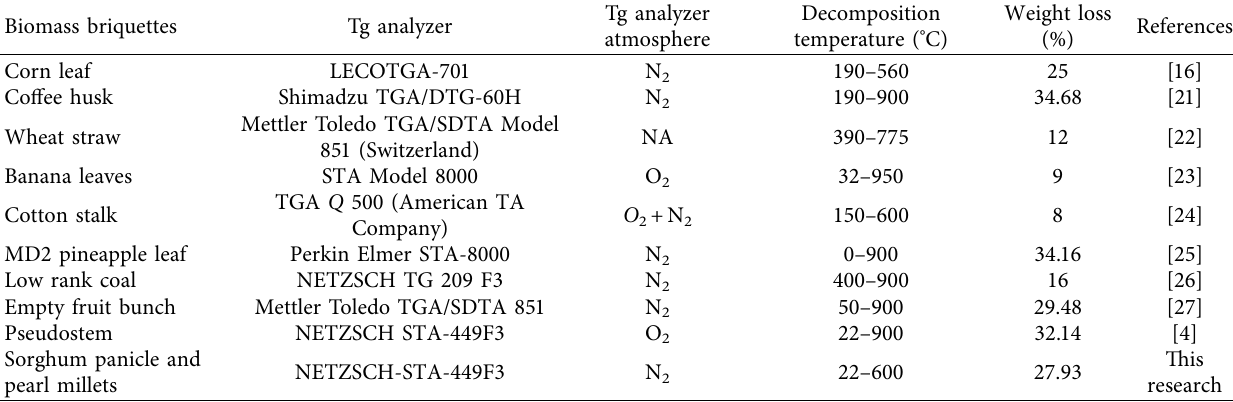
Table 2: Comparative study on thermogravimetric analysis of biomass